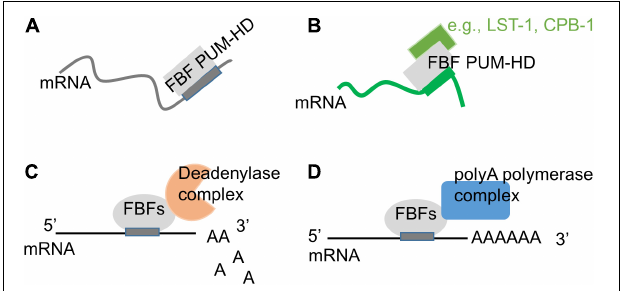
FIGURE 3 | Modification of FBF biological activity though interactions with protein partners. (A) On its own, FBF PUF domain binds to target mRNAs containing a canonical 9-nt motif (Wang et al., 2009; Bhat et al., 2019; Qiu et al., 2019). (B) FBF PUF domain’s RNA-binding specificity can be influenced by interactions with protein partners such as CPB-1 (Menichelli et al., 2013) and LST-1 (Qiu et al., 2019). (C) FBFs can repress target mRNAs by recruiting deadenylase complex (Goldstrohm et al., 2006; Suh et al., 2009). (D) FBFs can promote mRNA polyadenylation by interacting with the poly(A) polymerase complex (Eckmann et al., 2002; Suh et al.,